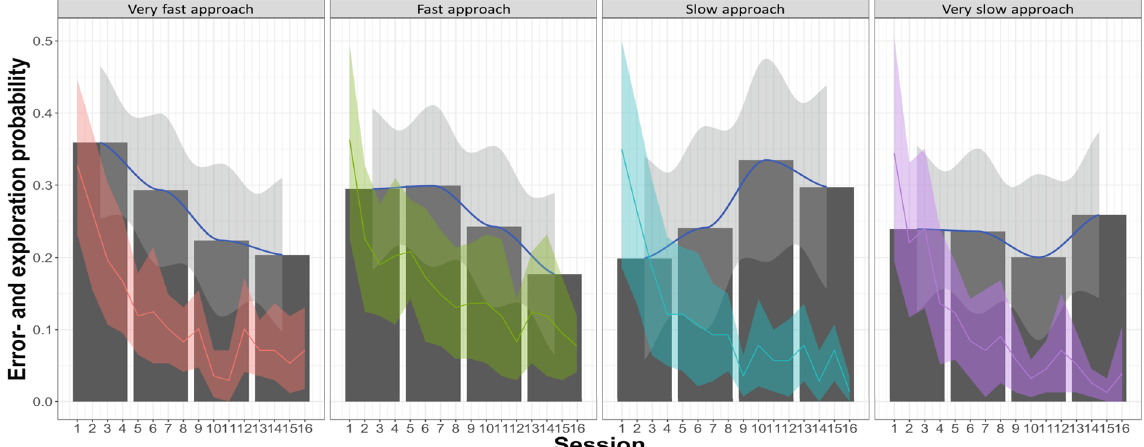
Figure 4. Bars show mean corrected probability to commit novelty responses, in each of the four task quarters for different groups of neotic responses; blue line indicates the smoothed slope by local polynomial regression fitting (locally weighted scatterplot smoothing-loess); the coloured lines indicate the probability to respond to the unrewarded baseline stimuli; shaded areas represent 95% confidence intervals.